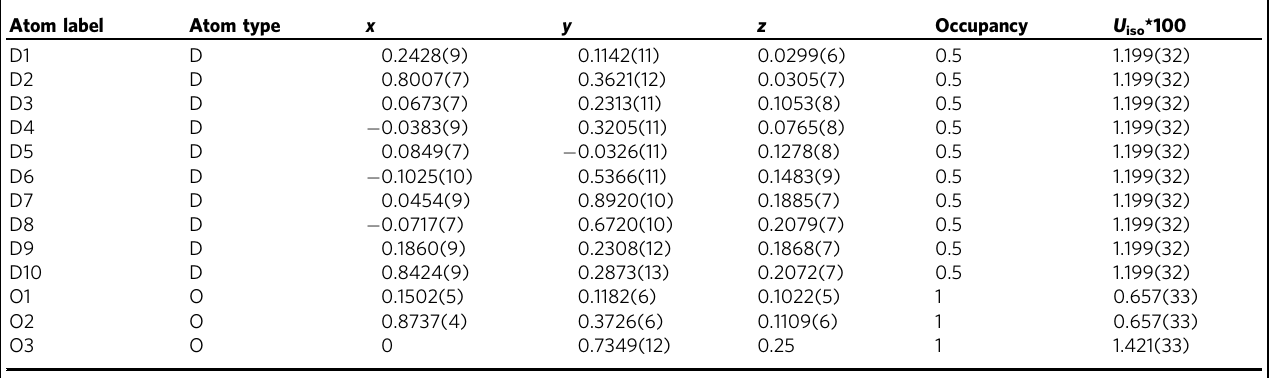
Table 1 Fractional atomic coordinates, fractional occupancies, order parameters, and isotropic atomic-displacement parameters ( U iso ) of DCl-doped D 2 O ice XIX at 100 K and ~1.6 GPa and using the Pbcn structural model. Atom label